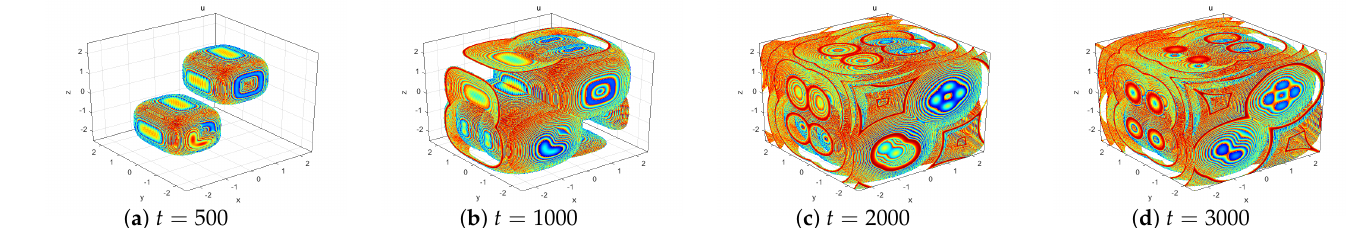
Figure 10. The patterns of u at K u = 1 × 10 − 4 , ε = 0.0001, µ = 0.01, β = 0.5, N = 512, and α =